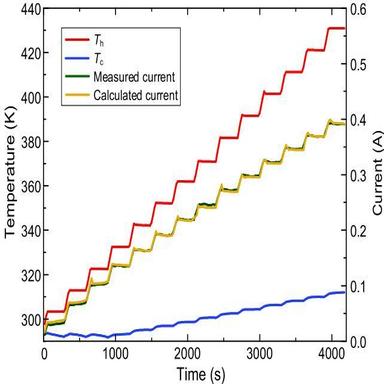
The TEG outputs by the tests and corresponding transient model.